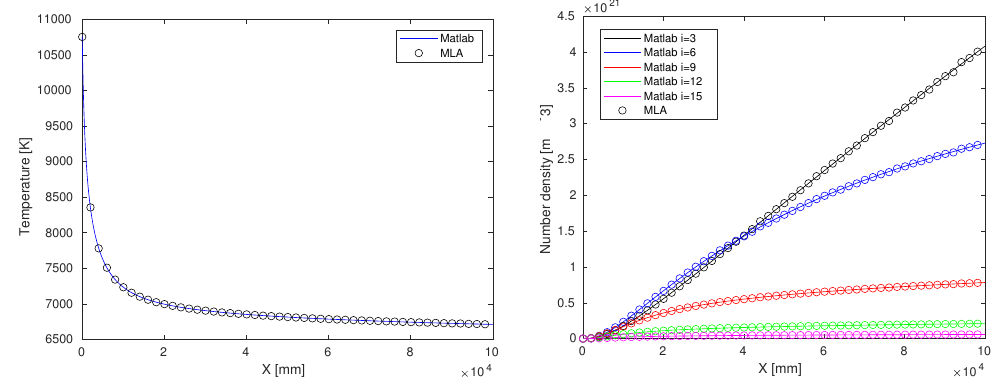
Figure 5. Comparison of Matlab and machine learning solution for the 1D reacting flow behind the shock wave in state-to-state approach for binary N 2 /N